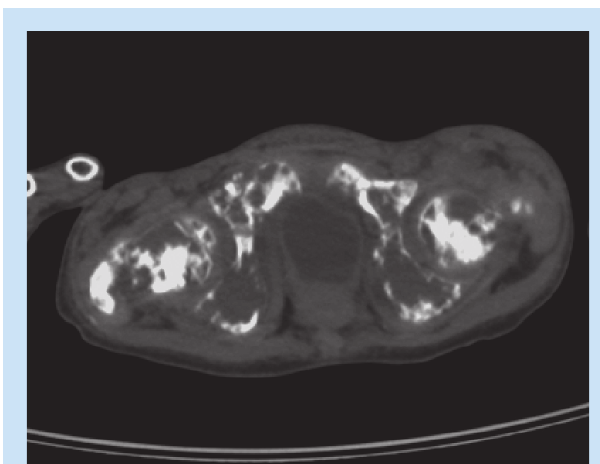
Fig. 2. Axial computed tomography scan in bone window at various levels demonstrating extensive lytic bone metastases.